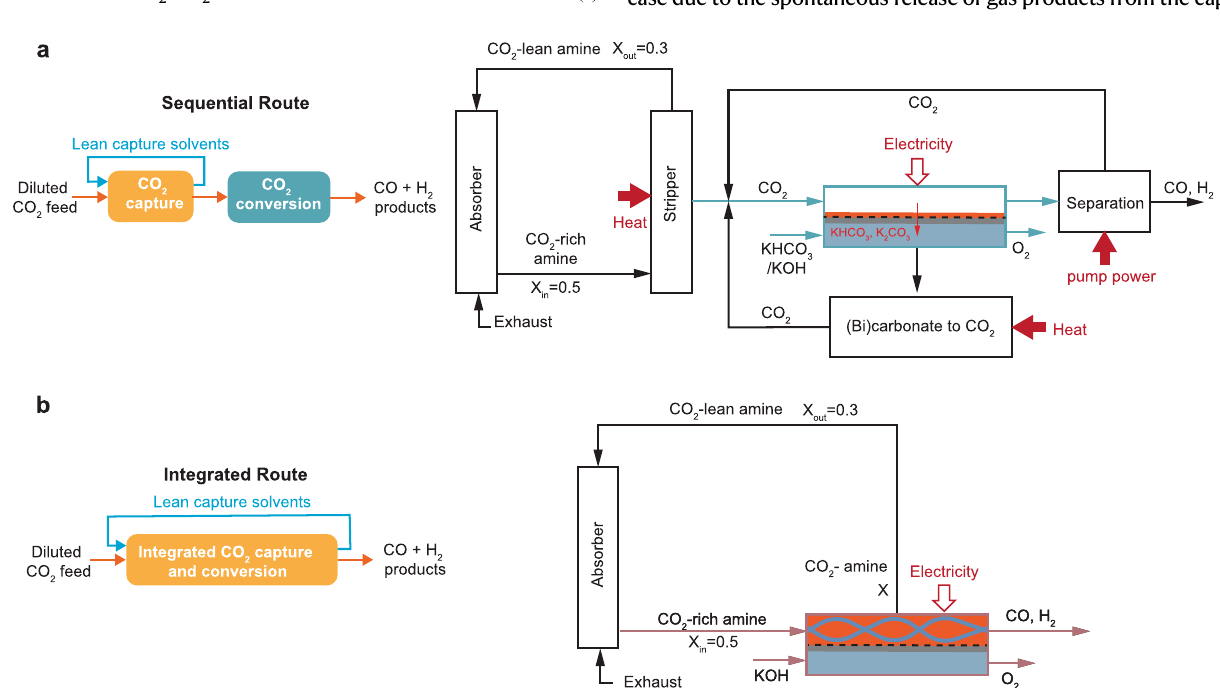
Fig. 1 | Sequential and integrated routes of CO 2 capture and conversion. a Schematicillustrationandblockdiagramsofthesequentialrouteforamine-based CO 2 capture and electrolysis to produce CO. CO 2 electrolyser is based on membrane-electrodeassemblies. b Schematic illustration and block fl ow diagrams